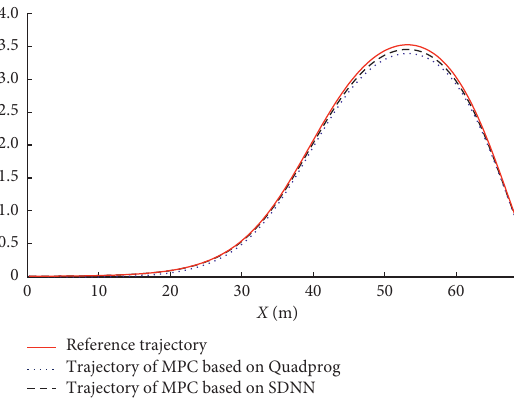
Figure 24: Trajectories on the curved road.